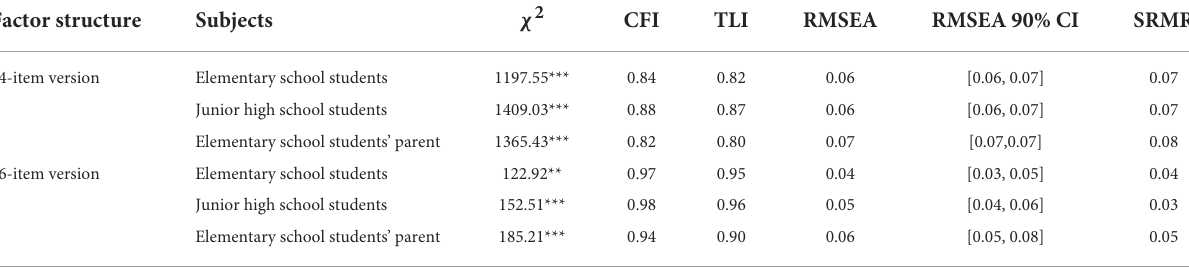
TABLE 4 Goodness-of-fit indices of CFI for the power to live questionnaire. Factor structure